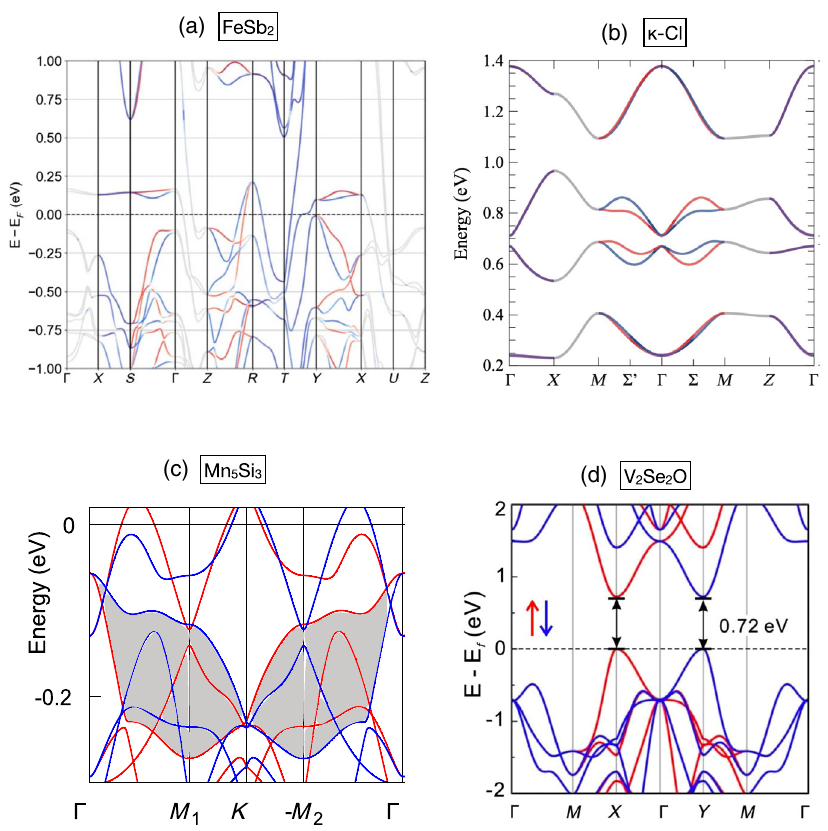
FIG. 7. (a) – (d) Ab initio spin-split band structures of depicted altermagnetic candidate materials. This figure is adapted from Refs. [6,7,15,116].